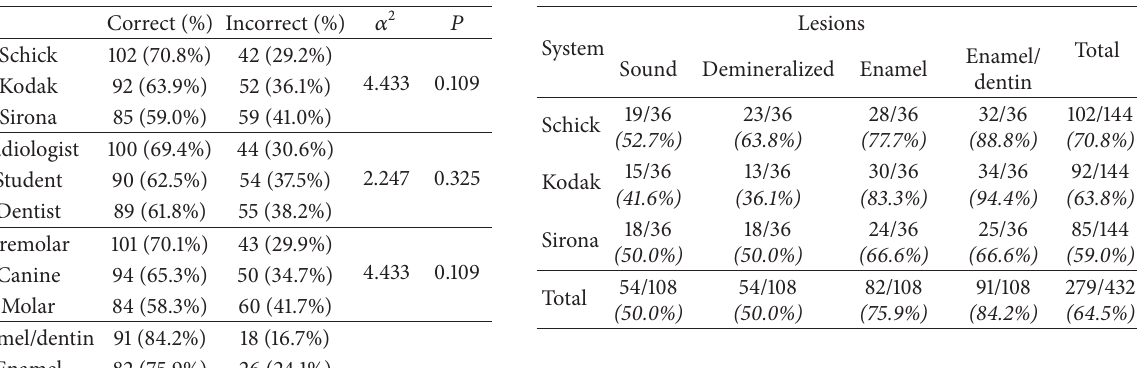
Table 1: Frequency of correct and incorrect diagnoses according to radiographic system, rater, type of tooth, and type of lesion.